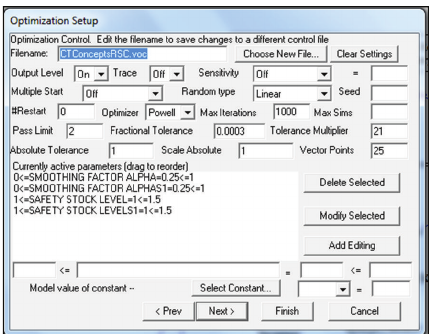
Figure7:Selectingthesearchrangefortheparametersforoptimiza- tion